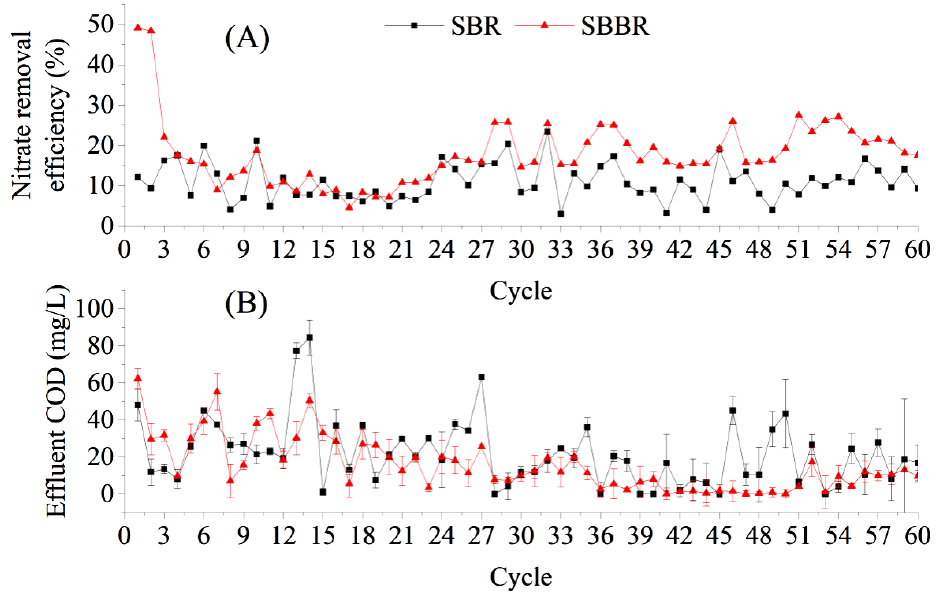
Figure 6. Performance of aerobic denitrification flora for NO 3 − –N and chemical oxygen demand (COD) removal of bagasse-loaded sequencing batch biofilm reactor (SBBR) for treating low C/N wastewater. ( A ) Nitrate removal efficiency in SBR and SBBR; ( B ) Effluent COD in SBR and SBBR.